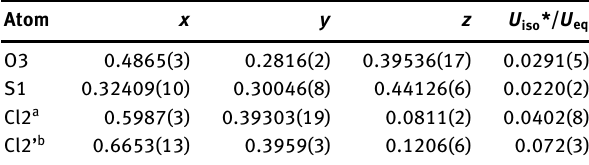
Table 2: Fractional atomic coordinates and isotropic or equivalent isotropic displacement parameters (Å 2